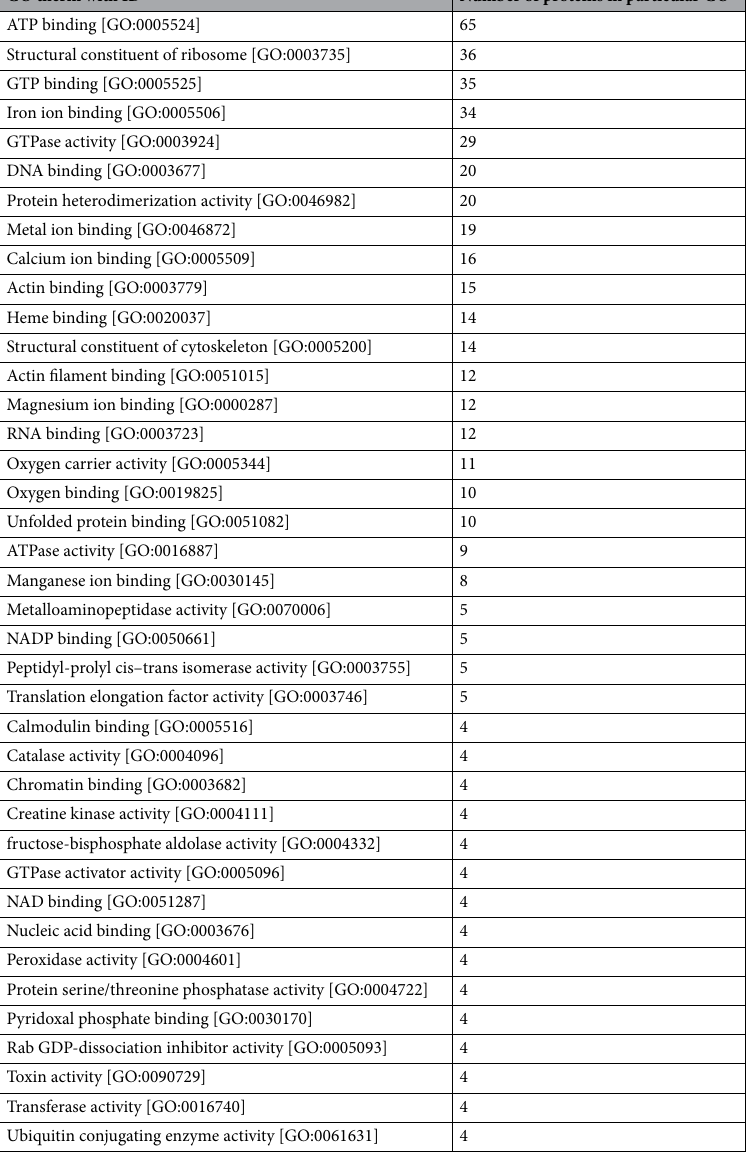
Table 1. Molecular functions of proteins (with the number) identified in